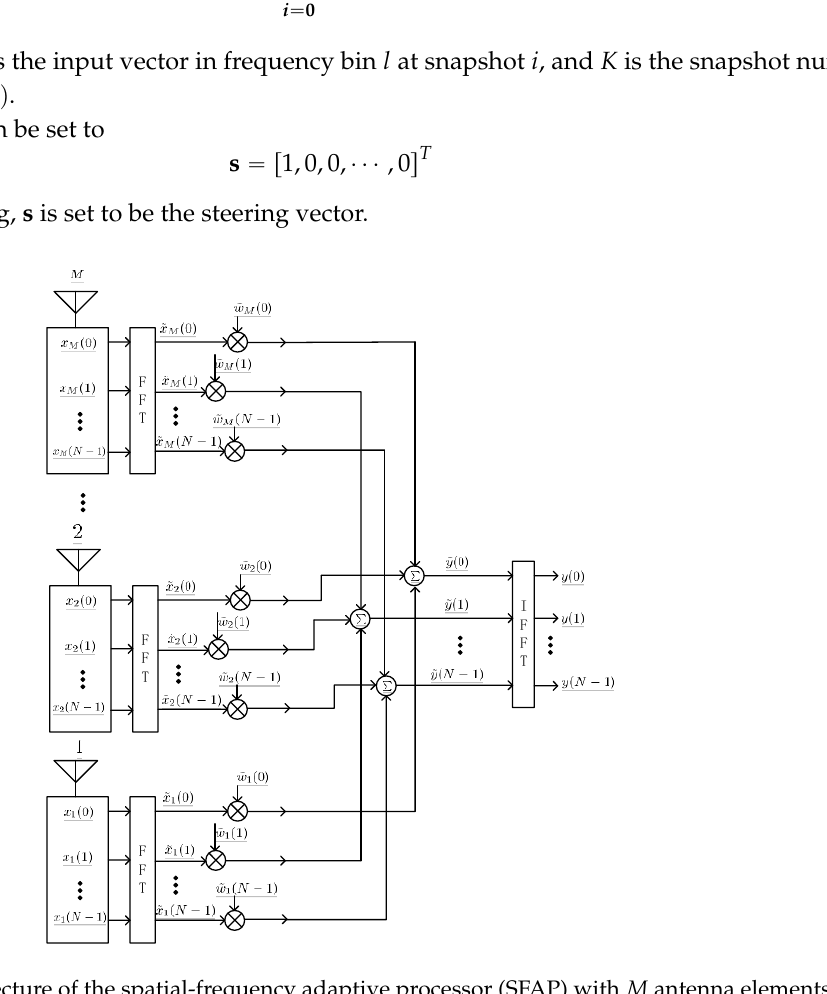
Table 3. Configuration parameters of the Spatial-frequency adaptive processor (SFAP) and their value range.